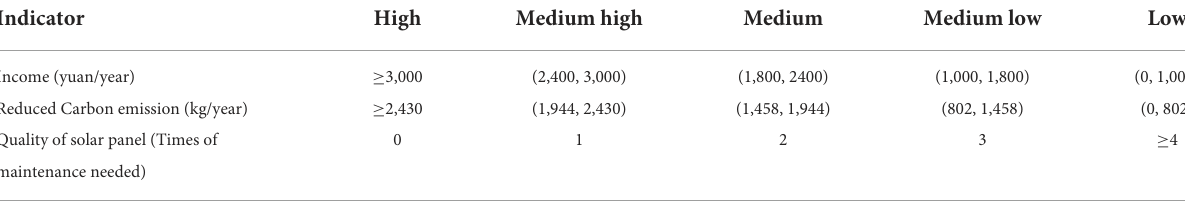
TABLE 4 Indicators using quantitative data and the transformation criteria to fuzzy evaluation. Indicator High Medium high Medium Medium low